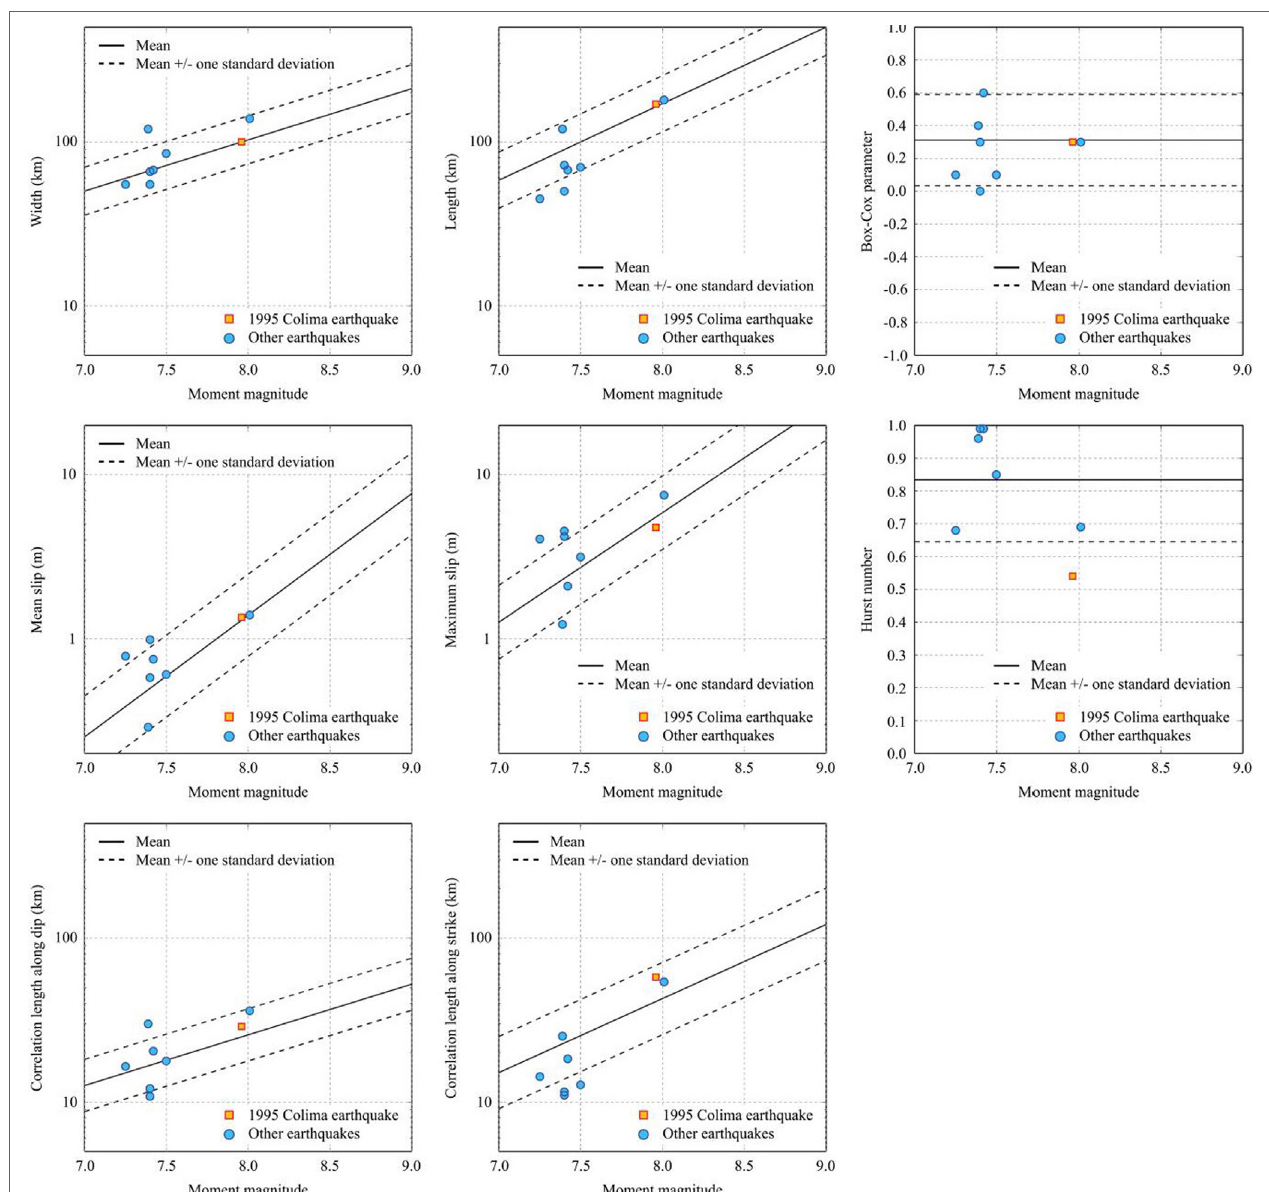
FigUre 3 | Comparison of the estimated source parameters for the eight finite-fault models of the Mexican subduction earthquakes with the corresponding scaling